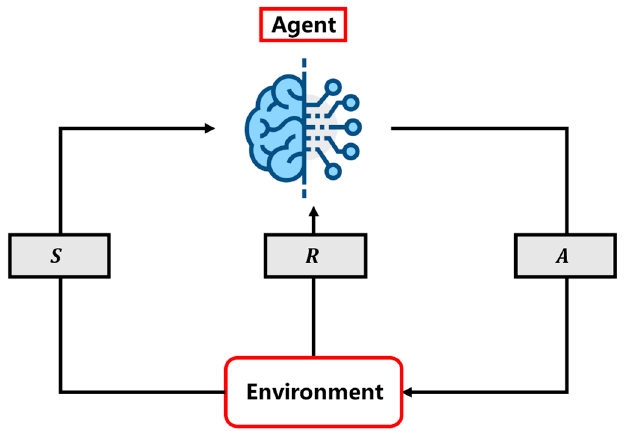
Figure 2. Schematic diagram of reinforcement learning algorithm.